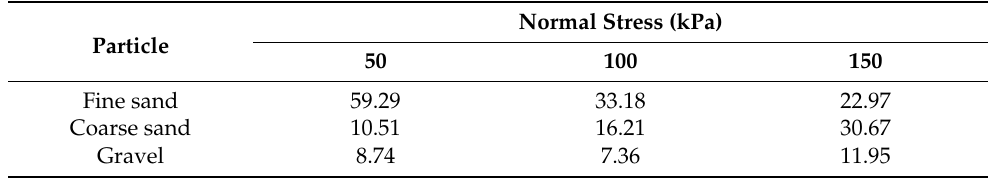
Table 3. Percentages of shear strength variation (%) for fine sand–biaxial geogrid, coarse sand–biaxial geogrid and gravel–biaxial geogrid